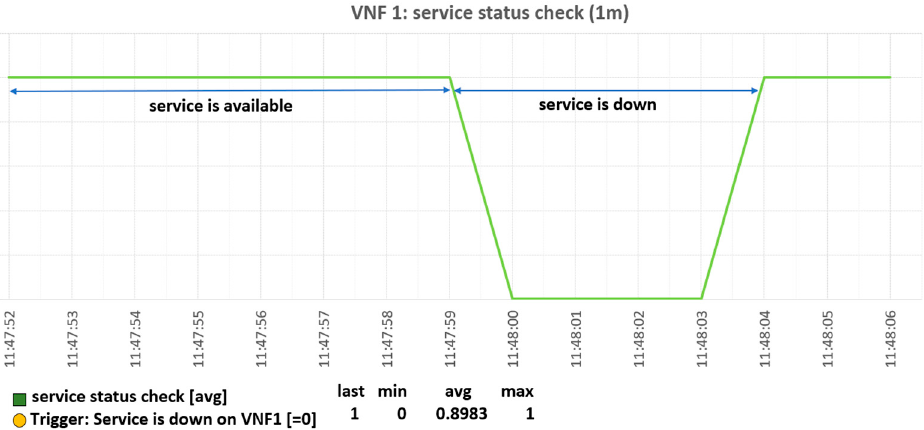
Figure 10. Monitoring result in the monitoring server.